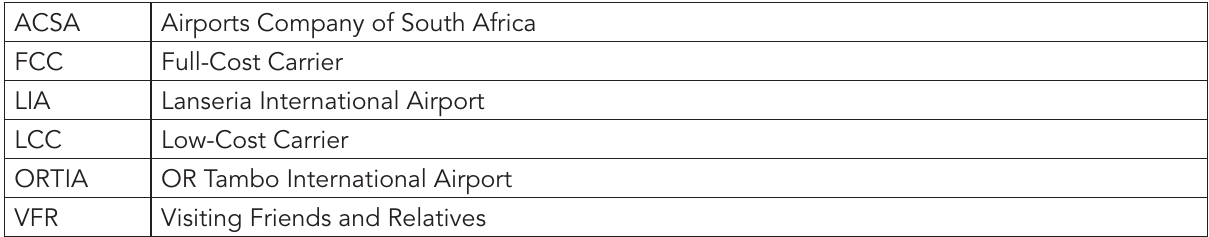
ACSA Airports Company of South